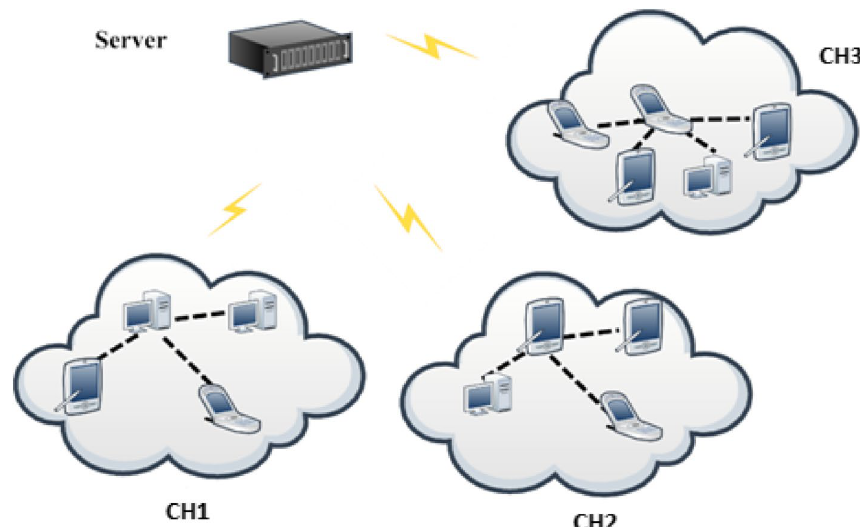
Fig. 4 Traffic management in